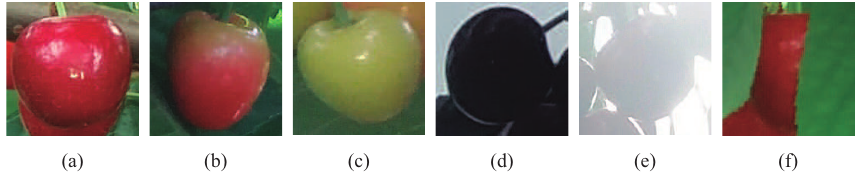
Figure 3. Examples of cherries in the dataset. ( a – c ) different stages of maturity, ( d,e ) dark and light illumination, and ( f )